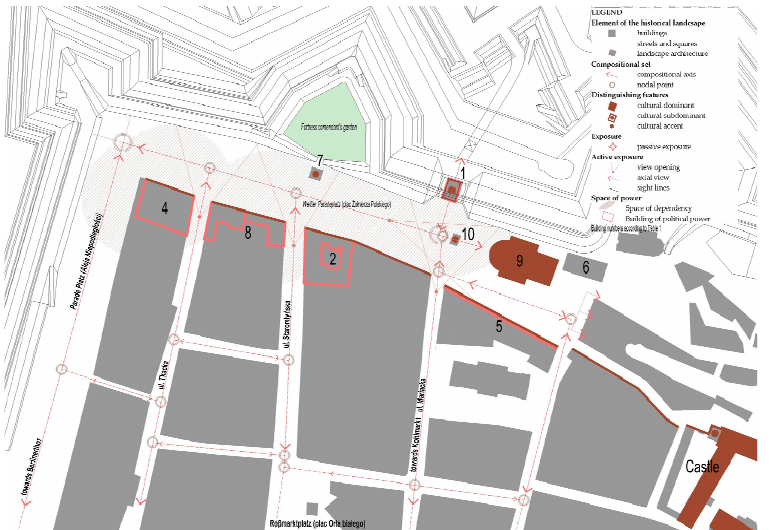
Figure 8. Landscape analysis of plac ˙Zołnierza Polskiego in 1850. The main composition of the square’s interior has not changed, as seen when compared to the illustration in Figure 7. The space of the square was supplemented with symbols and signs (7, 10—royal monuments) emphasizing its representative and servile function in relation to the ruler. In the eastern part of plac ˙Zołnierza Polskiego, the City Theatre (9) was erected, which became the spatial dominant of this interior. This building, located at the widest point of the square, adjoined the northern elevation to the fortress ramparts. The theatre was erected on the main axis of the square (source: created by author).